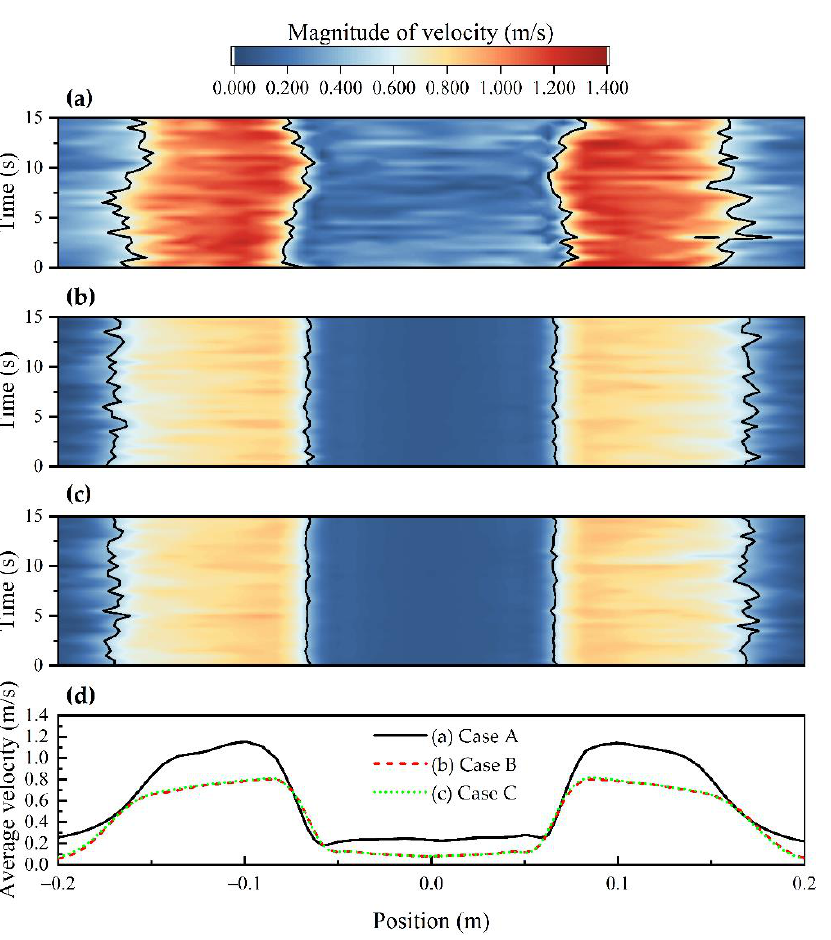
Figure 11. Spatiotemporal velocity plots (on the yellow line in Figure 9b) of the nozzle jet discharging from nozzle ports: ( a ) Case A; ( b ) Case B; ( c ) Case C; ( d ) an analysis of the time-averaged velocity. All four diagrams have the same horizontal coordinates. The black curve in the first three diagrams corresponds to the spatiotemporal average velocity.